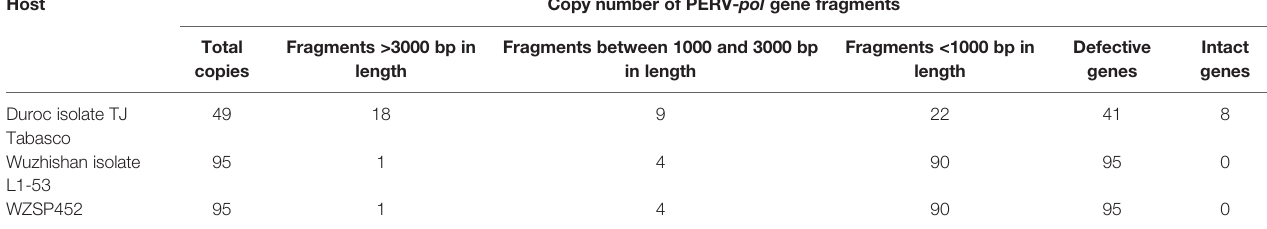
TABLE 2 | Copy number of PERV- pol gene in pig genomes.